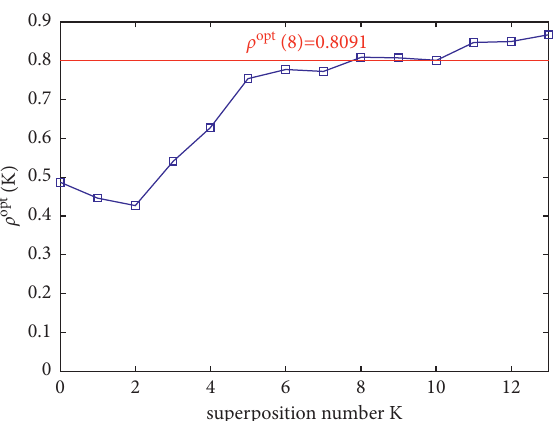
Figure 20: The variation curve of ρ opt ( K ) with the increase of the superimposition number K .